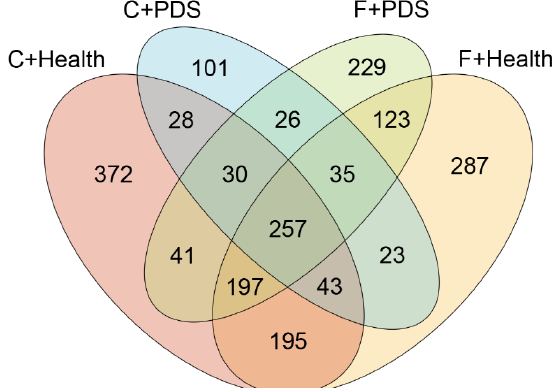
Figure 1. Operational taxonomic unit distribution across the analyzed fecal content. Venn diagram representing the number of unique and shared operational taxonomic units among the four groups: healthy sows plus control diet group (C + Health, n = 7), sows with postpartum dysgalactia syndrome (PDS) plus control diet group (C + PDS, n = 3), healthy sows plus B. licheniformis -fermented product group (F + Health, n = 6), and sows with PDS plus B. licheniformis -fermented product group (F + PDS, n =